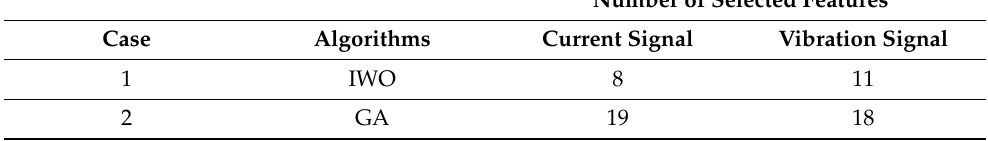
Figure 9. Loss curves of Genetic Algorithm. ( a ) Applying stator current signal (𝐼 (cid:2870) ); ( b ) Applying the vibration signal. Table 6. Number of selected features.